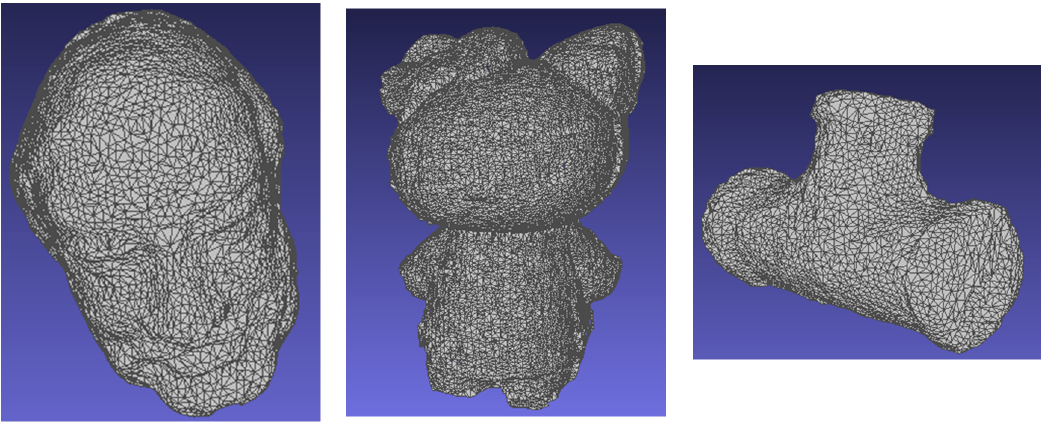
Figure 10. The triangle meshes of three objects being scanned by the developed method.